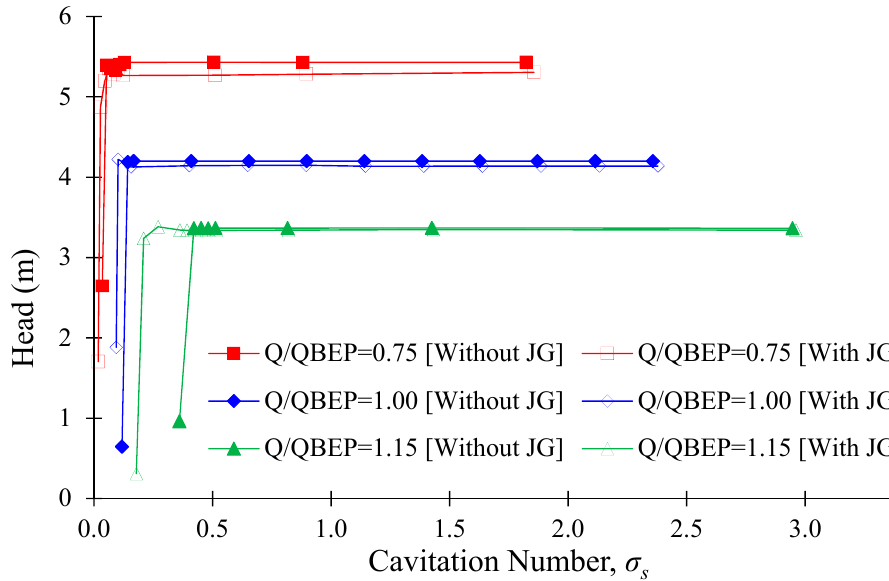
Figure 15. Suction performance comparison in the SCP model without and with J-Groove.